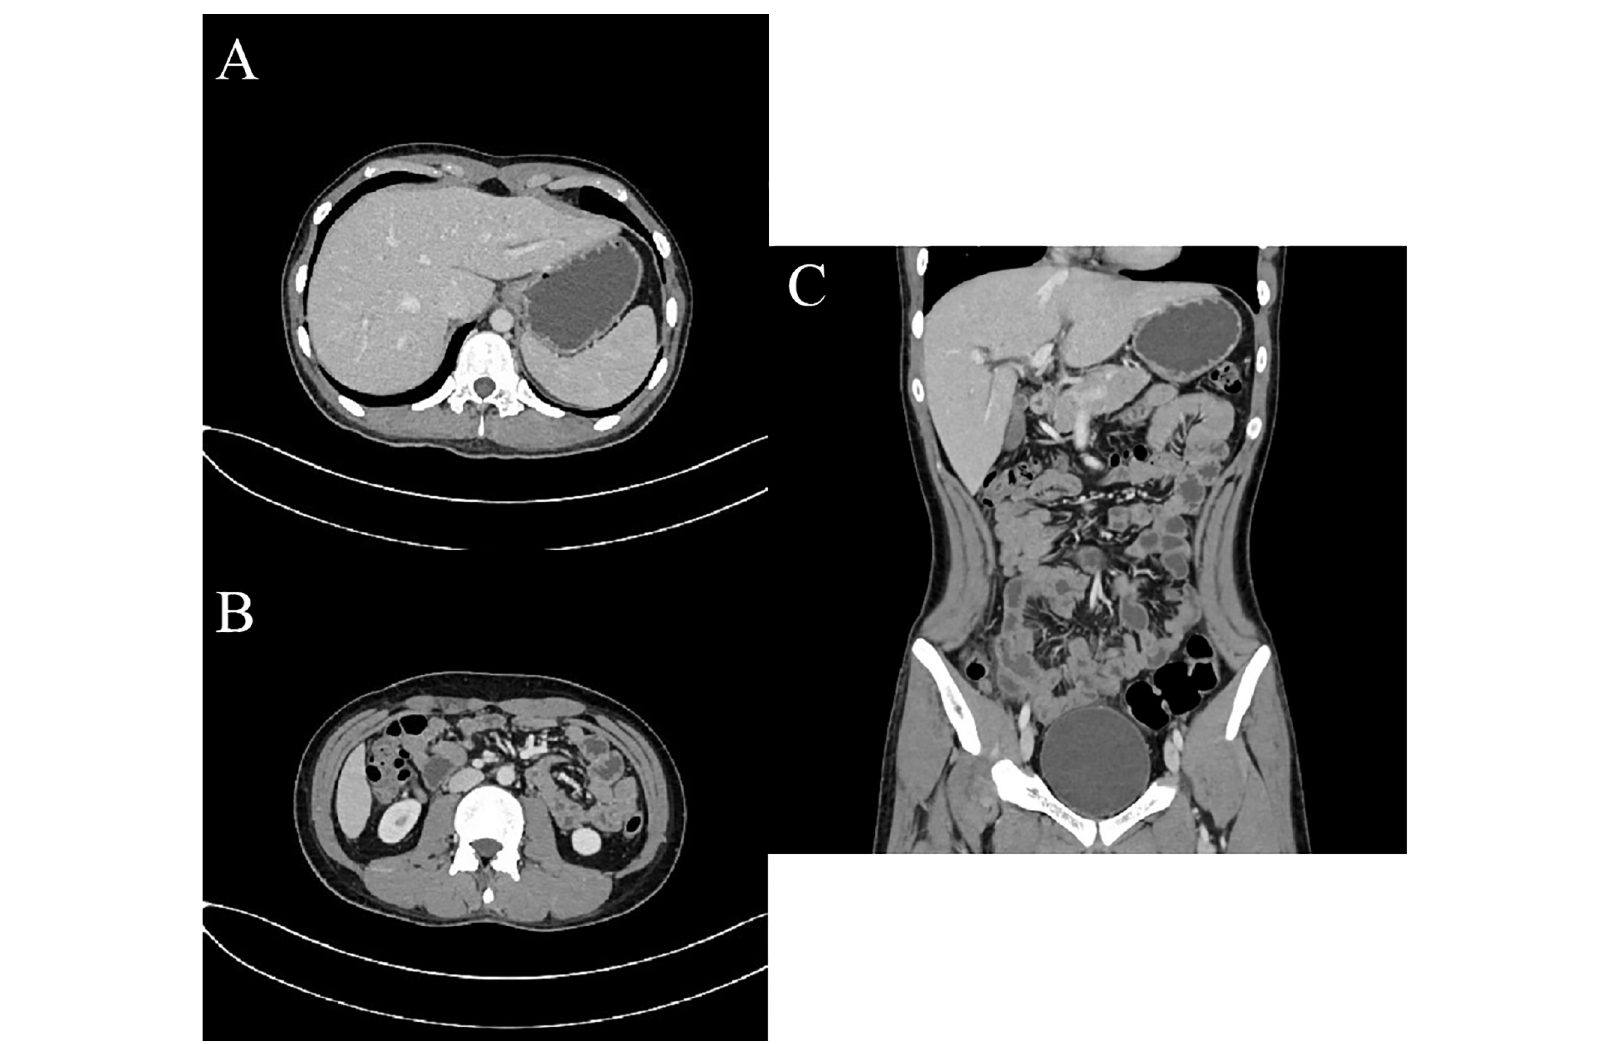
FIGURE 3 | CT examination post-treatment. Axial (A) , Axial (B) , and coronal (C) enhanced CT images of the abdomen and pelvis in the portal phase post-treatment demonstrated resolution of ascites, thickening of peritoneum and omentum disappeared and turned to the normal